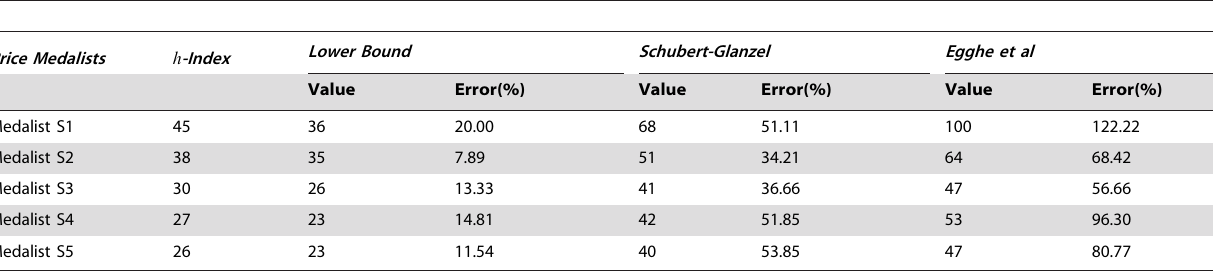
Table 5. Errors in the h -index using Theorem 2, Schubert-Glanzel model, and Egghe-Liang-Rousseau’s power law model [6] for the given set of Price